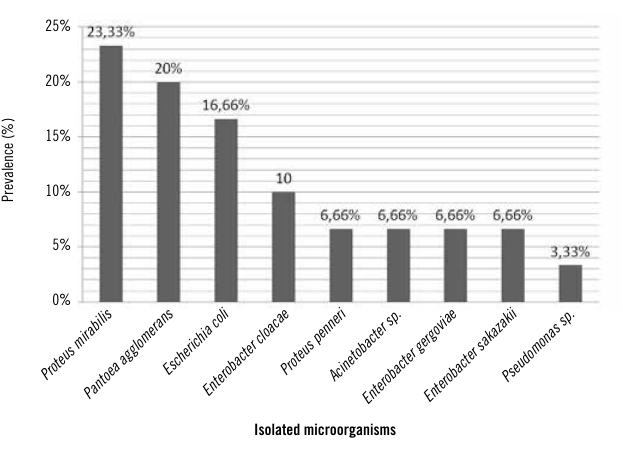
figurE 1 − Frequency of microorganisms isolated from analyzed blood cultures